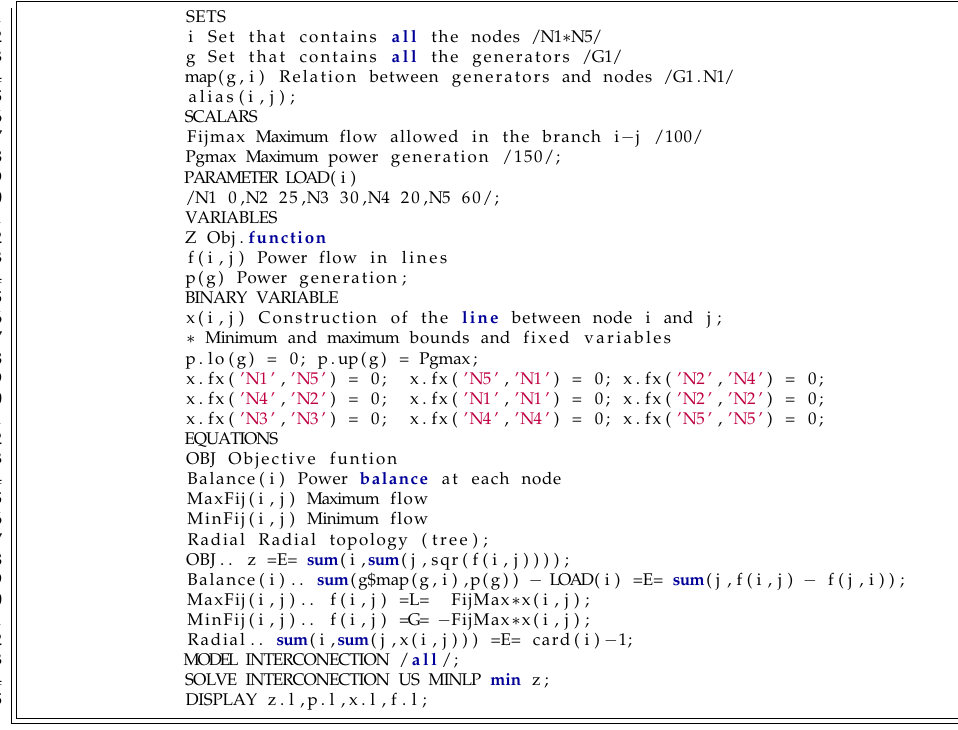
Figure 2. Example of the implementation of a nonlinear mixed-integer programming (MINLP) model by General Algebraic Modeling System (GAMS).